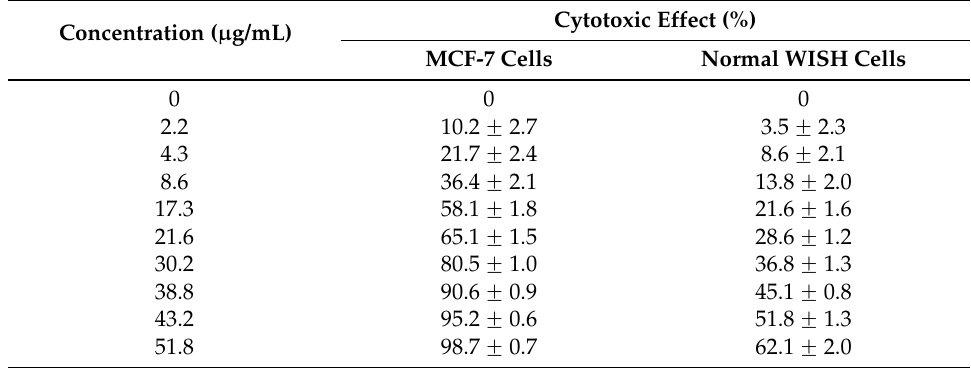
Table 1. Percentage of cytotoxic effect of fungal Ag NPs against MCF-7 and normal cell lines. Concentration (µg/mL)